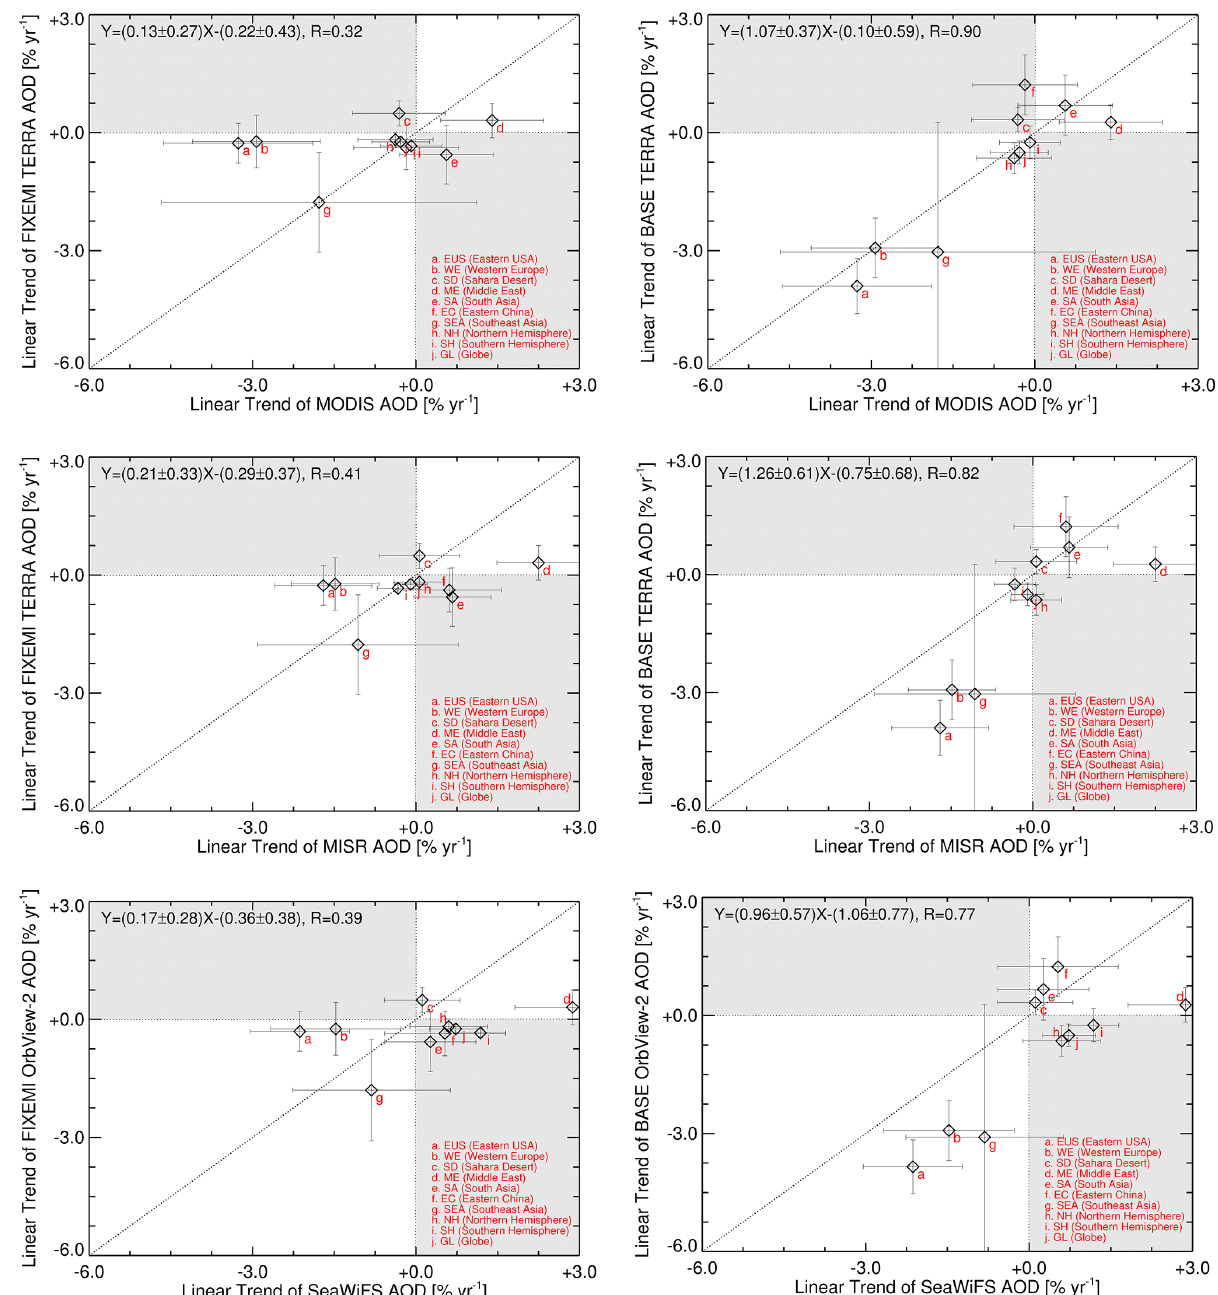
Figure 5. Linear trend between 2001 and 2010 in %year − 1 by regions from model and satellite observations. The trends estimated by observations are on the x axis. The trends estimated by simulations are on the y axis. The letters define the regions. The bars represent the 2 σ (i.e., 2 standard deviations) of the trends: top – data from MODIS data set; middle – data from MISR data set; bottom – data from the SeaWiFS data set; left – data from simulation FIXEMI; right – data from simulation